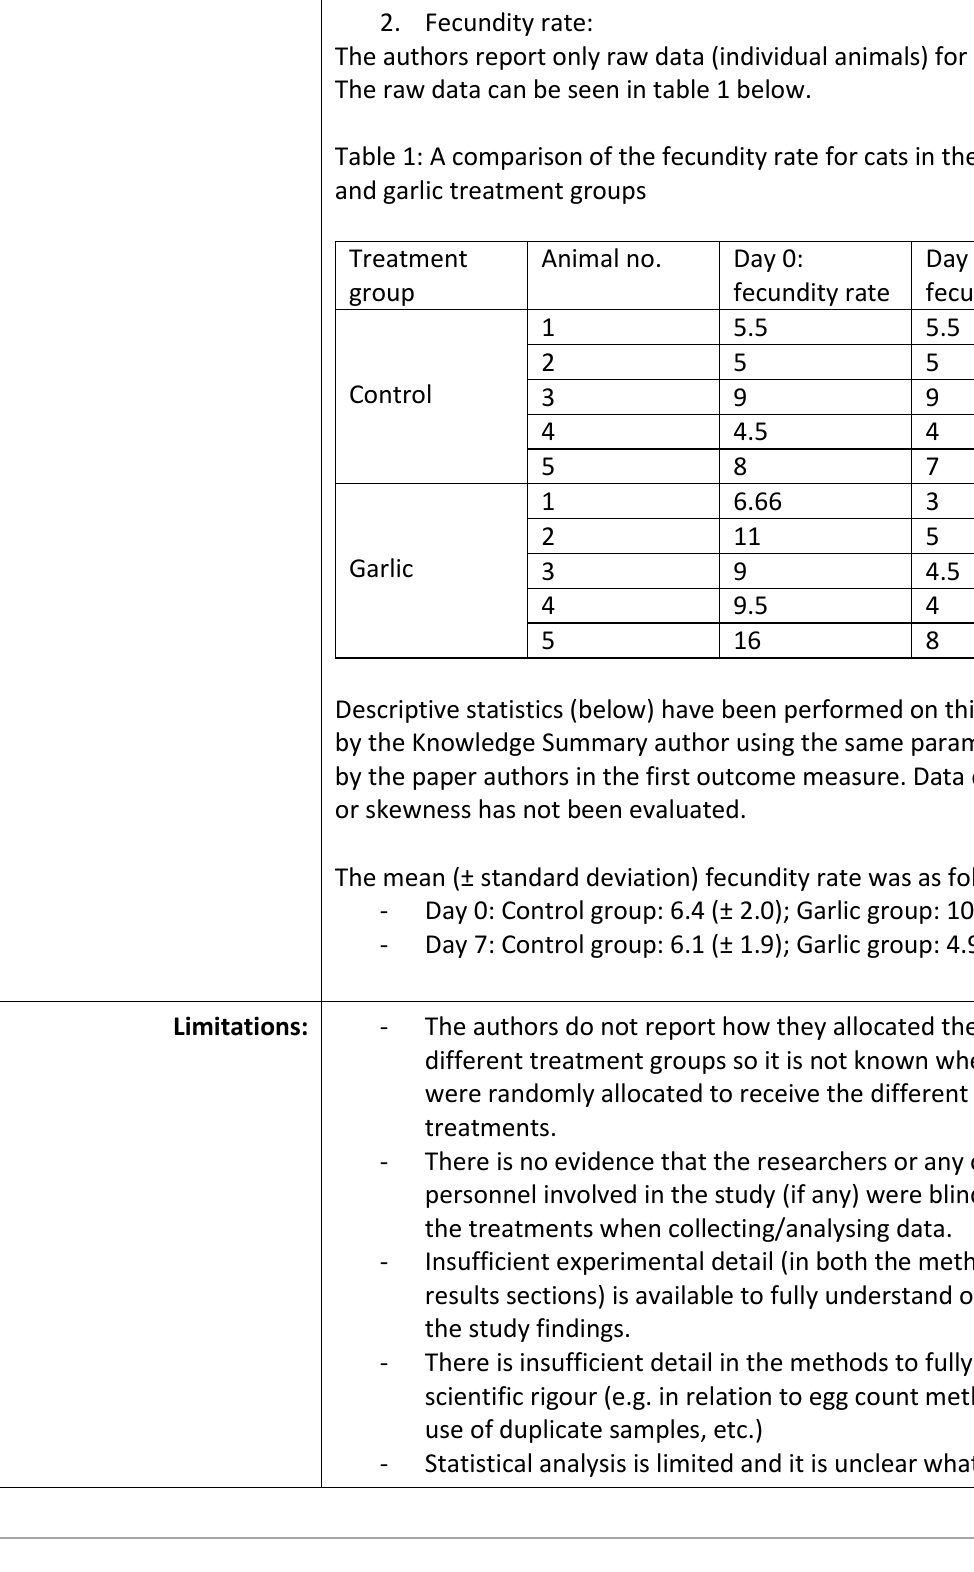
Table 1: A comparison of the fecundity rate for cats in the control and garlic treatment groups Treatment group